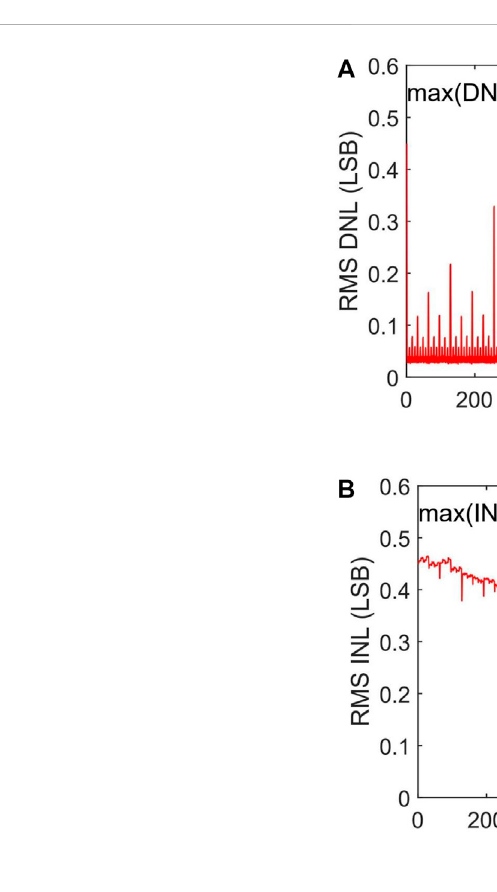
FIGURE 9 DNL and INL of DAC. (A) DNL. (B)